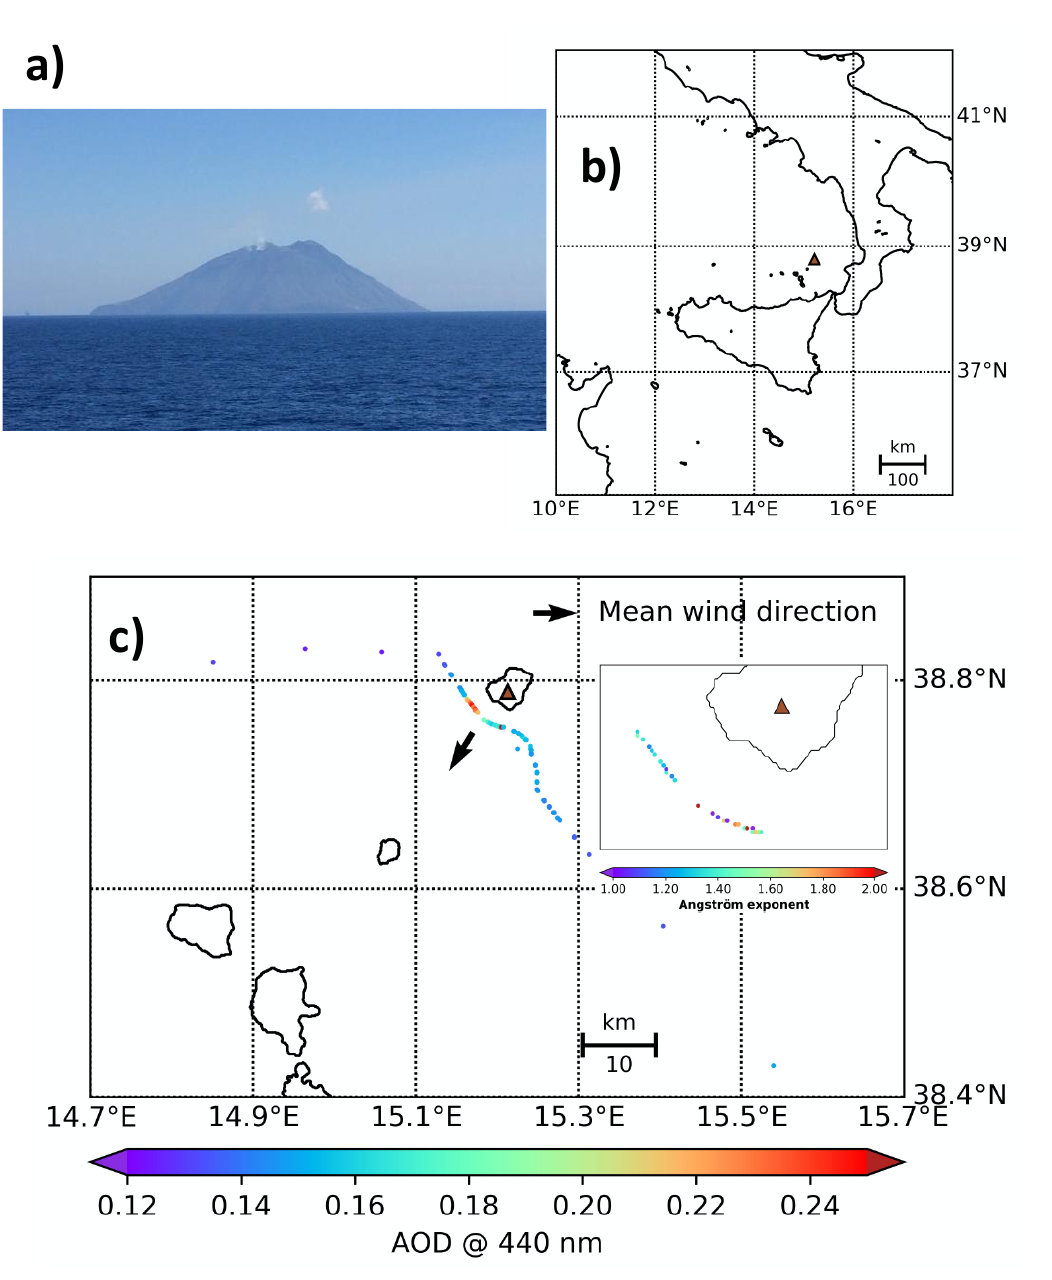
Figure 1. ( a ) Picture of Stromboli volcano during the measurement campaign, with a typical Strombolian explosion visible. ( b ) Location of Stromboli volcano (brown triangle) in the wider context of southern Italy. ( c ) MicroTops-II (MII) sun-photometric AOD observations at 440 nm before, during and after the section scan on Stromboli plume. The black arrow shows the average wind direction during the plume crossing. The Å ngström exponent (440/675 nm) for the section scan is shown in the inlet of panel c. Based on this first discrimination, we then carried out the atmospheric background correction of Eq. 1 and isolated the AOD P values for the Stromboli plume. Figure 2 shows the average AOD spectral values at the five MII channels for the atmospheric background AOD B ( ) (average of section 1) and the isolated Stromboli plume AOD P ( ) (average of atmospheric-corrected sections 2 and 3). The atmospheric background AOD B has typical